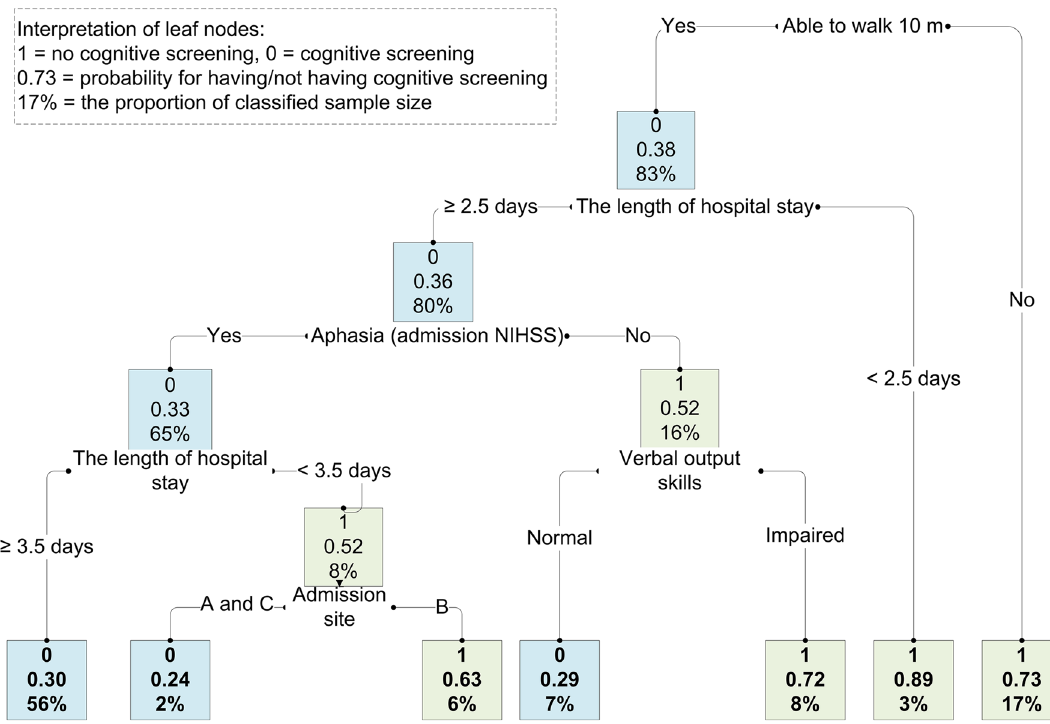
Figure 4. Decision tree with seven leaf nodes representing the decision-making process for cognitive screening. NIHSS The National Institutes of Health Stroke Scale, A and C admission sites without reperfusion treatment, B admission site with reperfusion treatment.